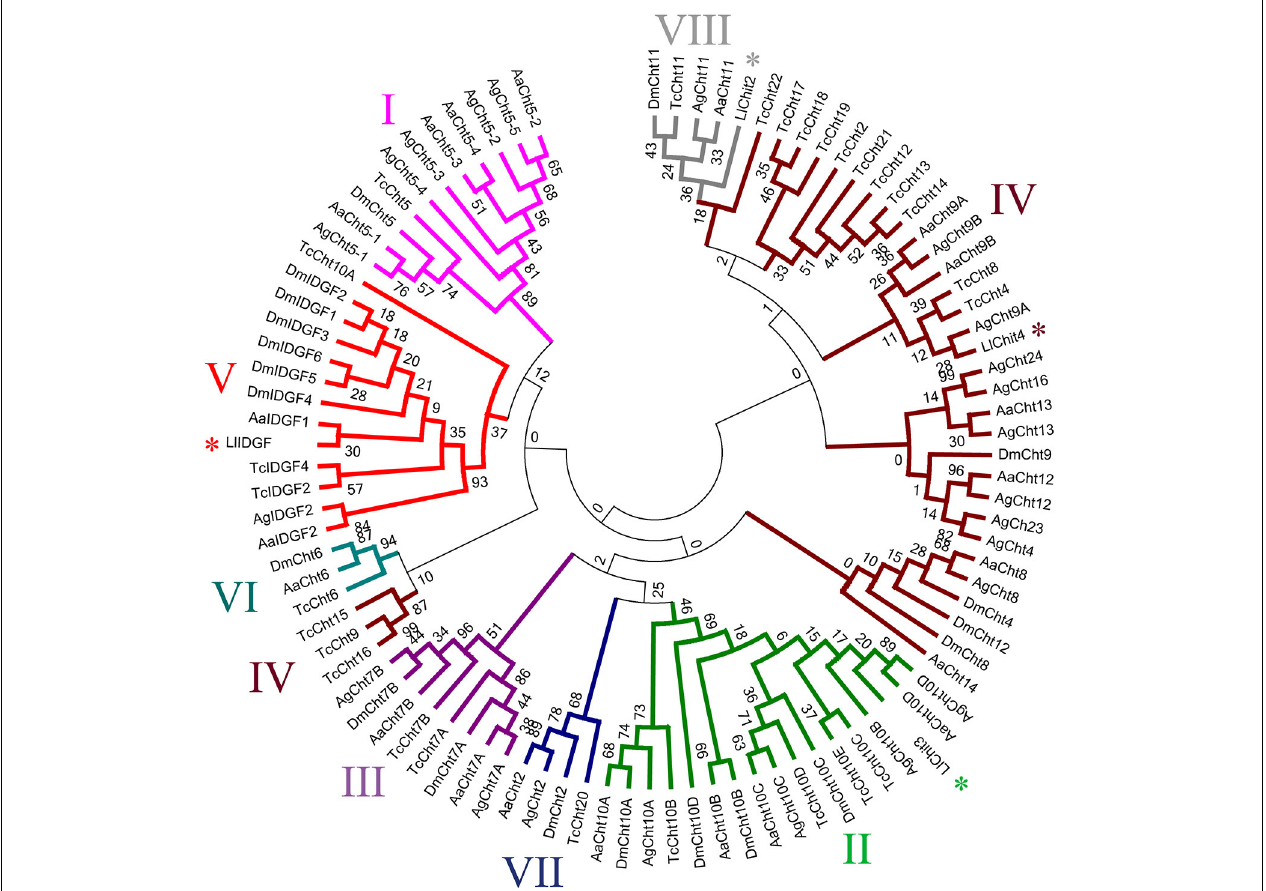
FIGURE 2 | Cladogram of selected insect GH18 protein sequences and positioning of L. longipalpis GH18 (LlChit2, LlChit3, LlChit4, and LlIDGF) in chitinase subgroups. Sequences are from: Aedes aegypti (accession number XP_001657537; XP_001656234; XP_001656233;